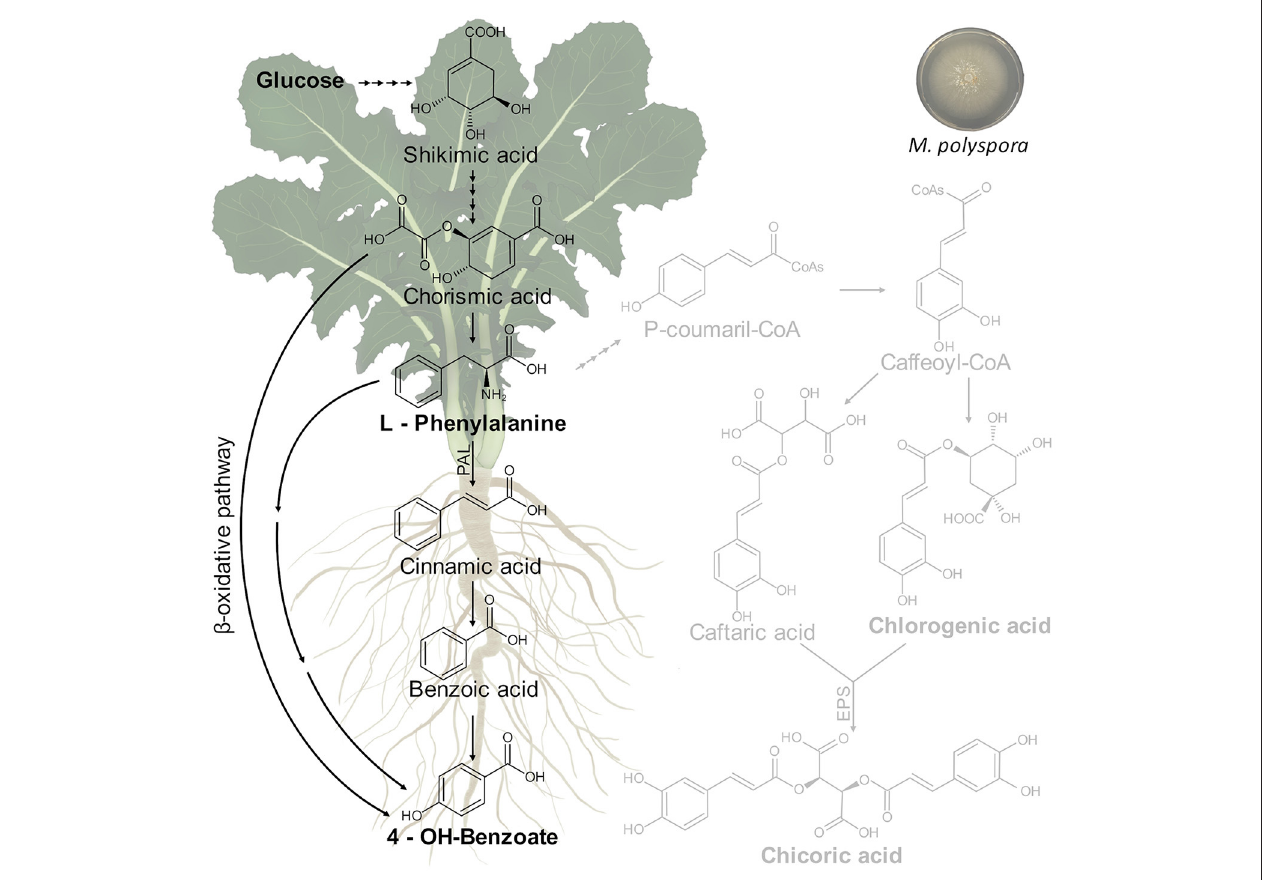
FIGURE 10 | Putative metabolic pathway involved in 4-OH-benzoate biosynthesis in C. intybus plant (root and shoot) after treatment with M. polyspora (503) culture filtrate.